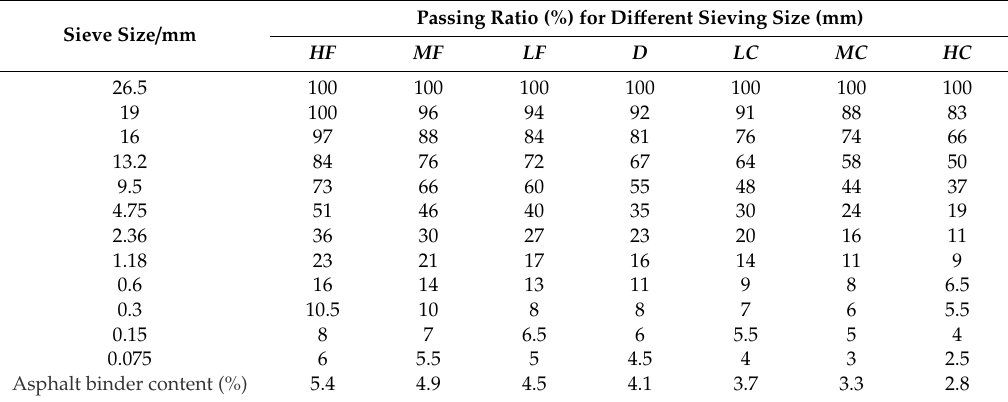
Table 2. Composition of asphalt